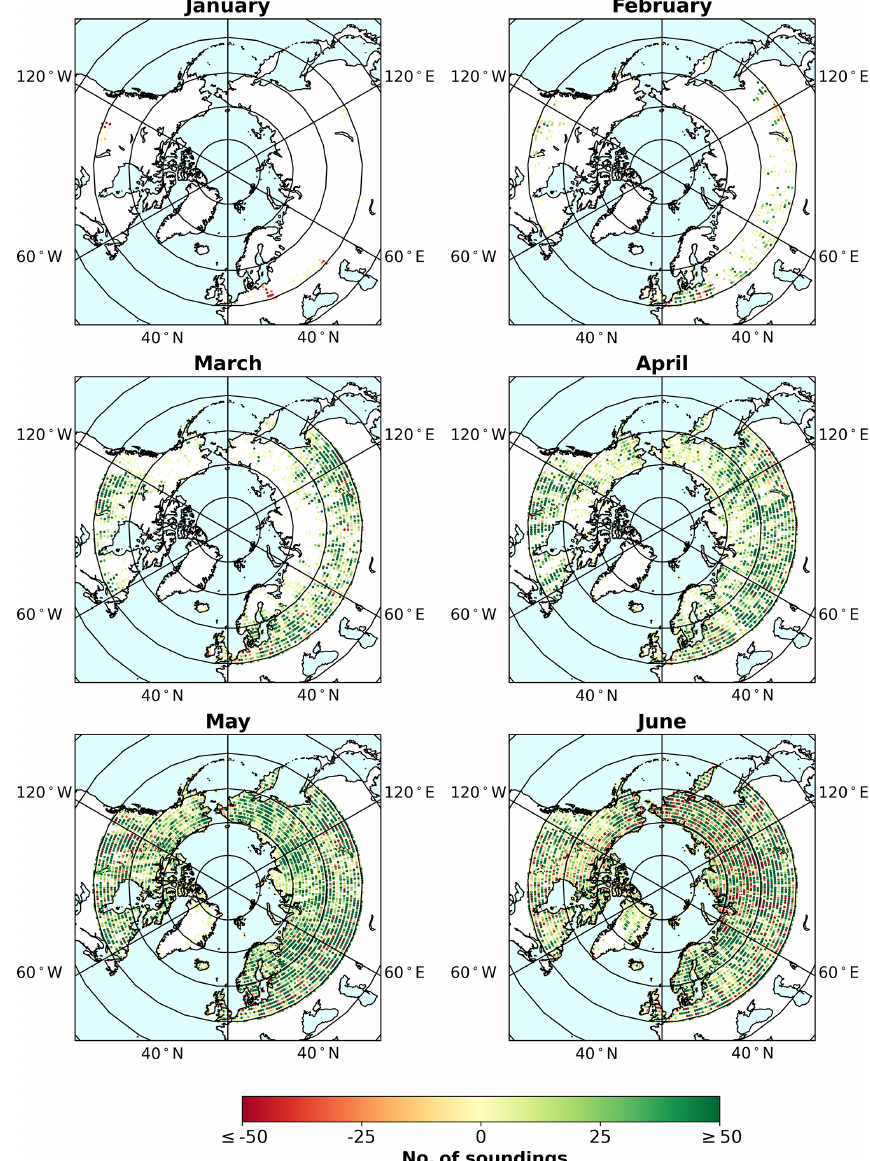
Figure 5. Maps of differences between the number of soundings passed by boreal QC and the number of soundings passed by B9 QC in each 1 ◦ latitude by 1 ◦ longitude grid cell in each month (January to June; summing all years from 2014 to